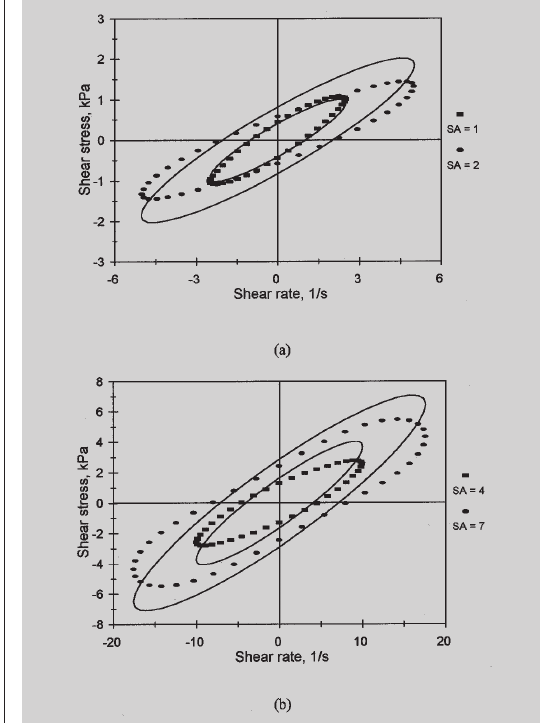
Figure 10 (left): The predicted shear stress ( ∑ ) versus shear strain rate loop (lines) for Mozzarella cheese at 60˚C using the relaxation spectrum determined from LAOS test compared with the experimental s versus g · loop ( ∑ ) (0.4 Hz, 1 £ g 0 £